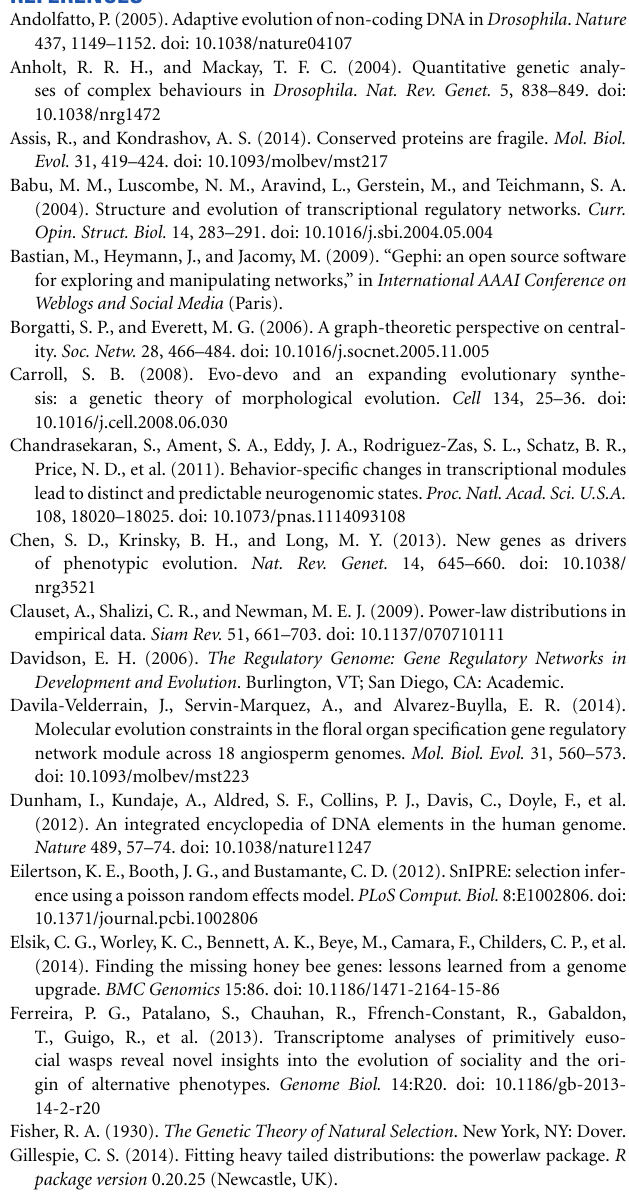
Figure S1 | Degree distribution of connectedness in the